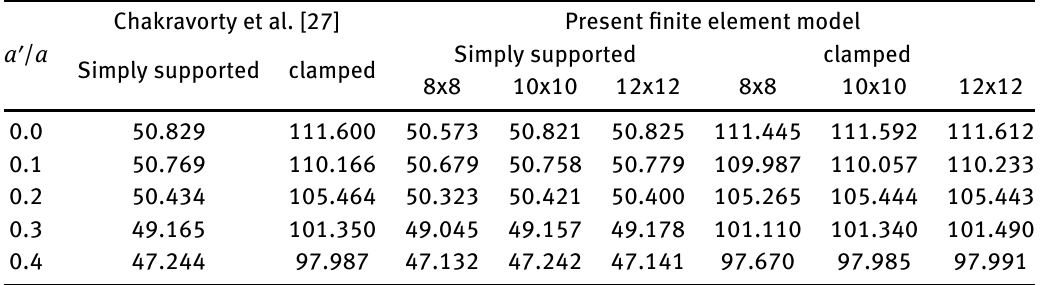
Table 2: Non-dimensional fundamental frequencies ( ω ) for hypar shells (lamination (0/90) 4 ) with concentric cutouts. Chakravorty et al. a ′/ a